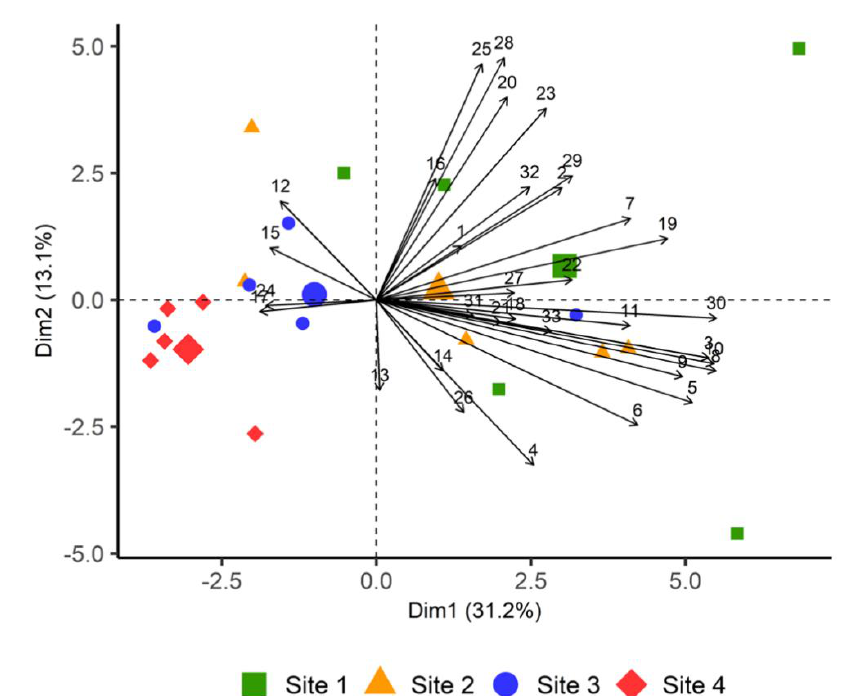
Figure 3. Principal components analysis (PCA) biplot showing PC scores of individuals and loadings of variables. PCA was based on 33 VOCs emitted by heather from all sites. The numbers in the graph indicate the following compounds; (1) hexyl acetate, (2) 1-hexanol, (3) ( Z )-2-hexenol, (4) ( Z )-3-hexenol, (5) ( Z )-3-hexenyl 2-methylbutyrate, (6) ( Z )-3-hexenyl acetate, (7) ( Z )-3-hexenyl benzoate,